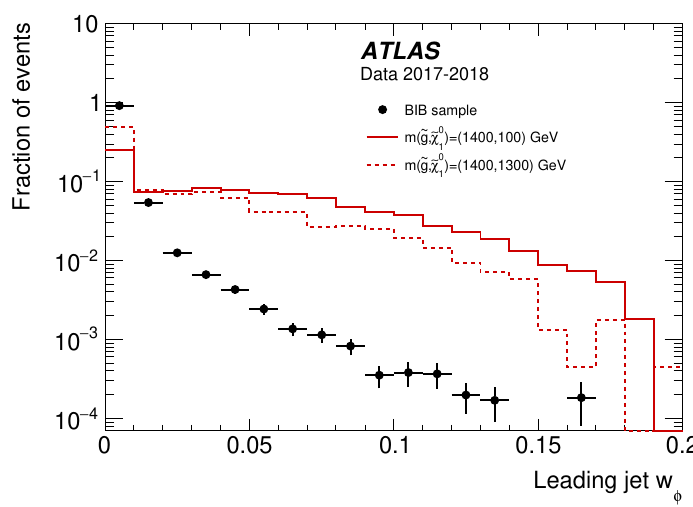
Figure 5 . Leading-jet w φ distribution for events passing preselection requirements in the BIB sample. Example signal models with a gluino mass of 1 . 4 TeV and a mass difference ∆ m = 100 GeV and 1300 GeV are overlaid. The last bin contains the